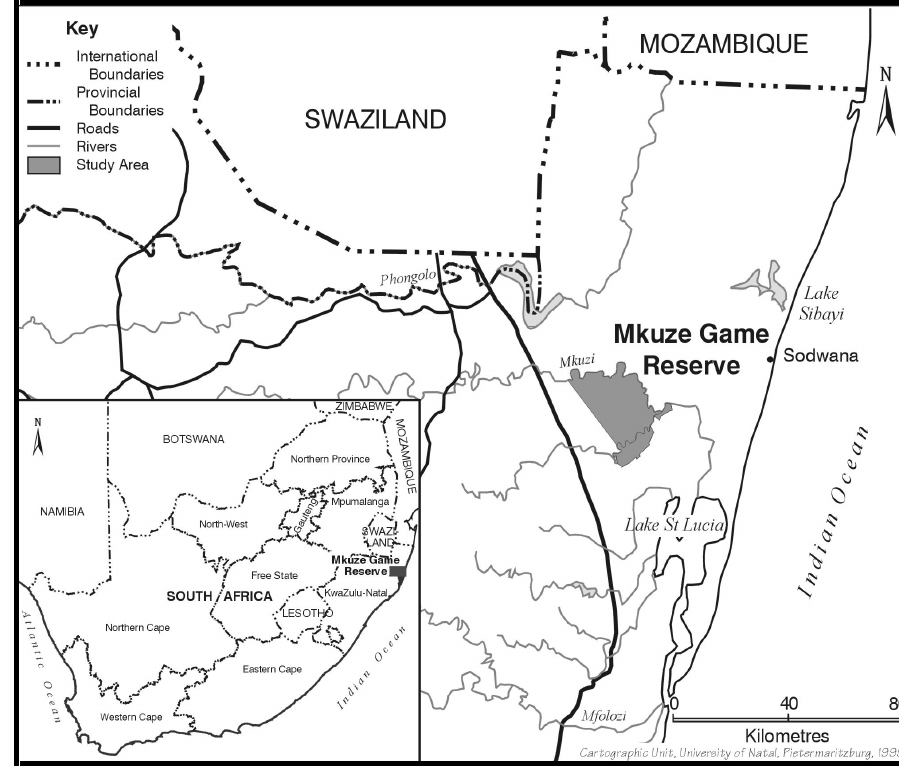
Figure 1. Site map of MGR in northern KwaZulu-Natal, South